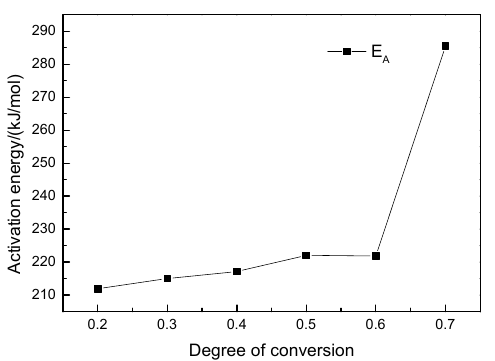
Figure 6. Activation energy as a function of fractional mass loss by the Friedman method under inert atmosphere.